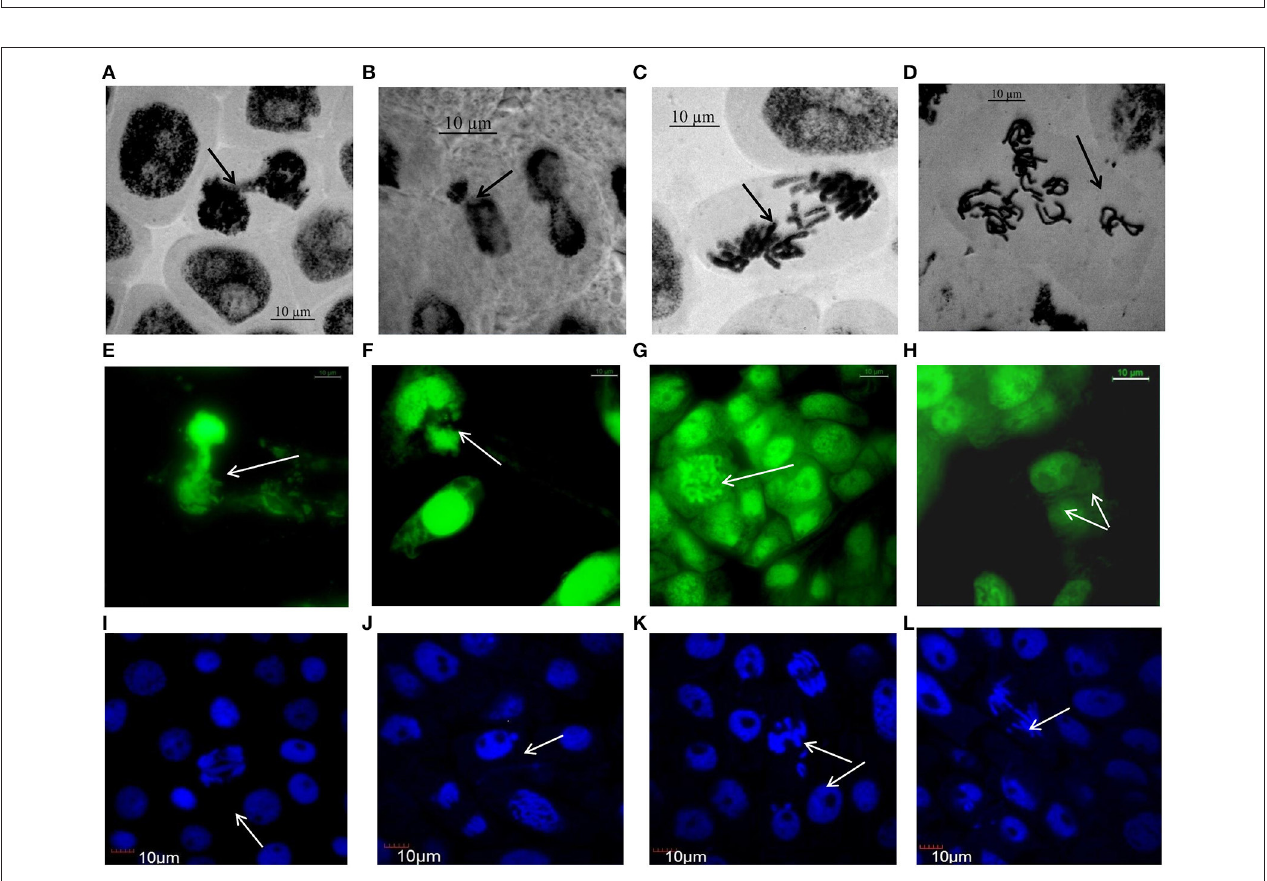
species used (Supplementary Table 1; Figure 5A ). From the study, it was thus evident that NiO-NP exposure causes cytotoxicity in the treated samples. The effectiveness of ENP suspension in progressive inhibition of MI can be expressed as A. fistulosum > A. schoenoprasum > A. sativum > A. cepa